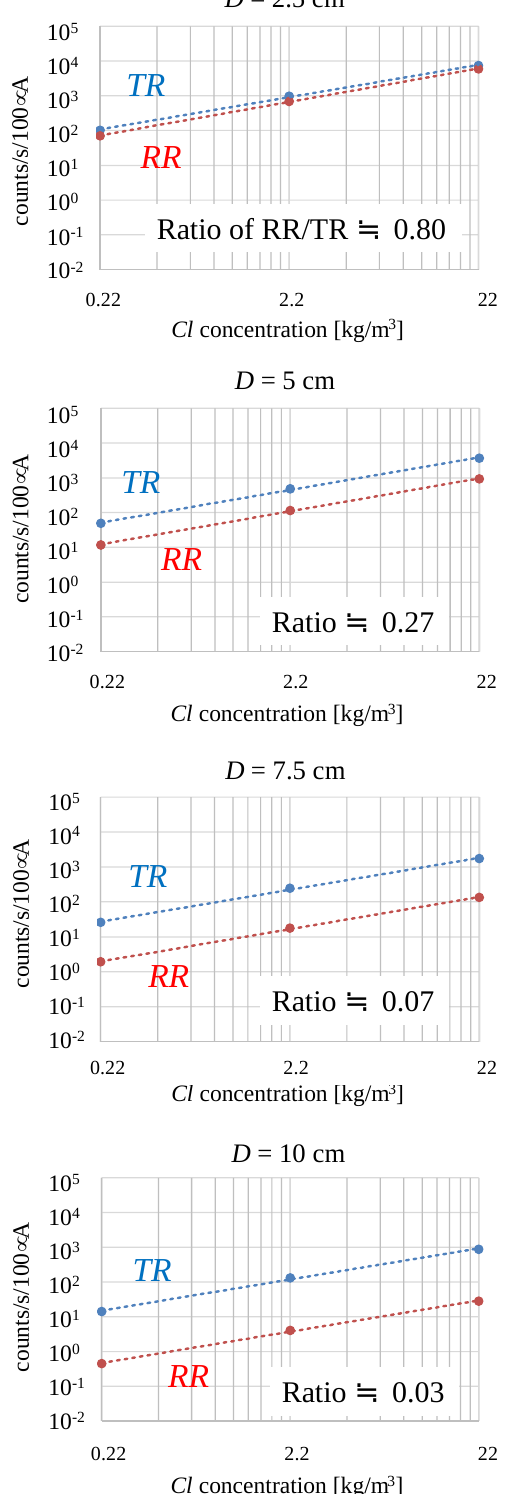
Figure 9 : Detection rate at the collimator angle of 40 degree for the 1951 keV γ -ray at each depth of interest D with chloride ion concentration of 0.22, 2.2, and 22 kg/m 3